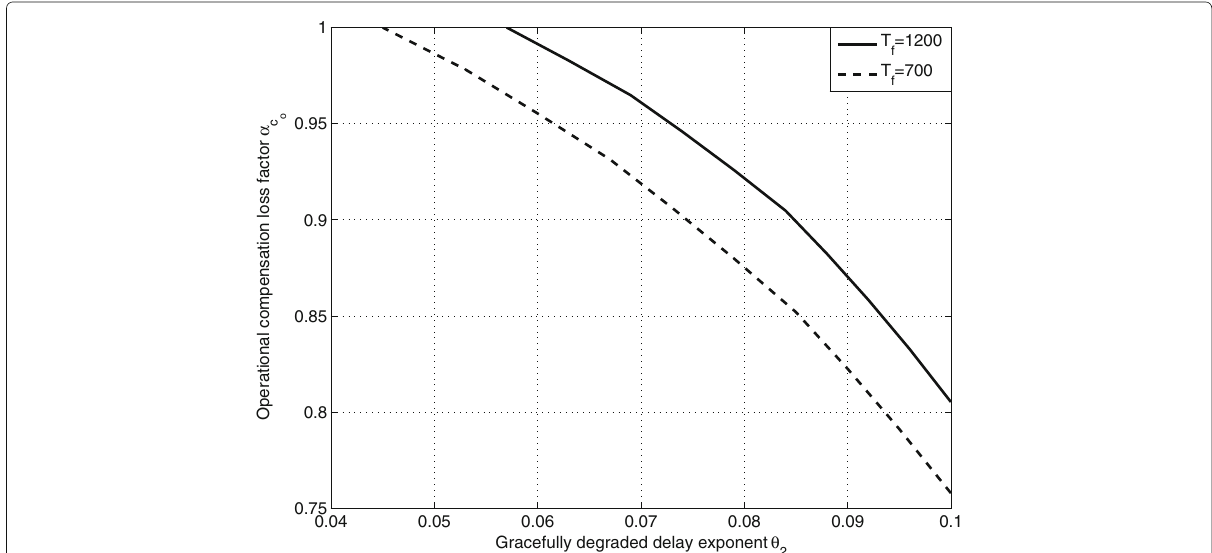
Fig. 8 Joint compensation trade-off. Trade-off between compensation loss factor via power control α c θ 2 for different operational